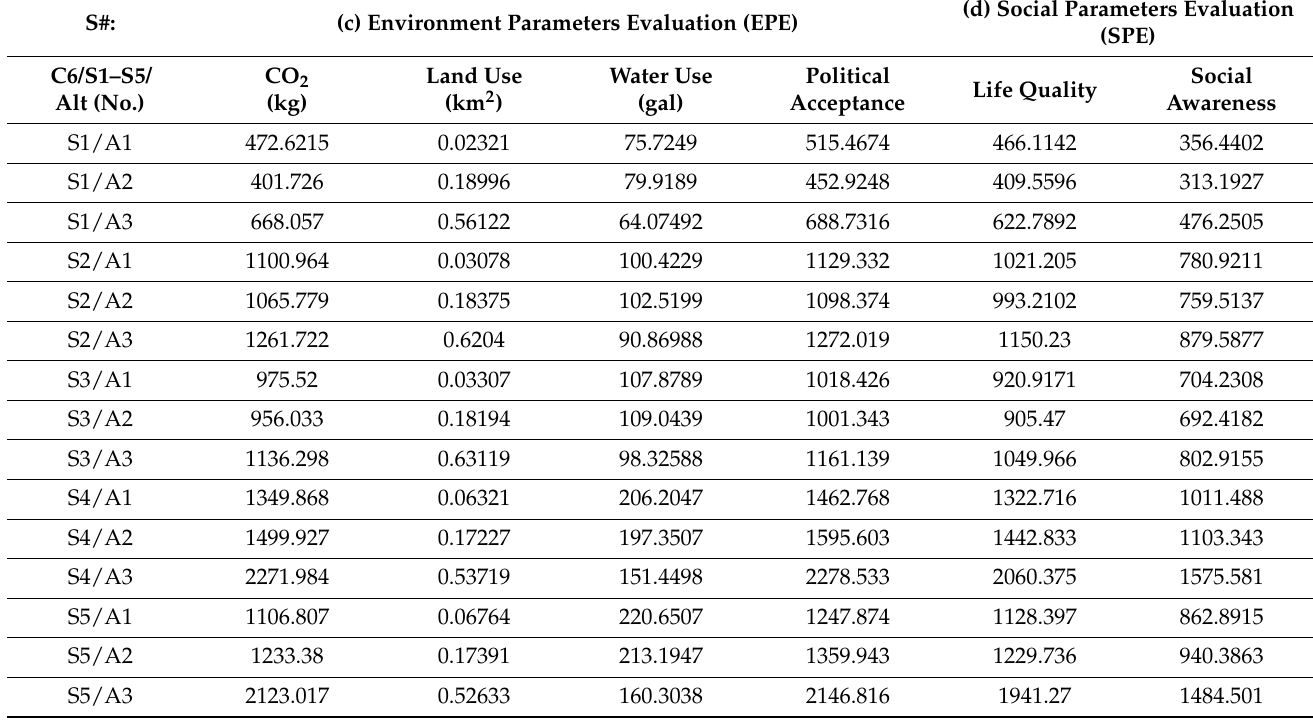
Table 27. EPE/SPE evaluations in C6/S1–S5 for the 75-bus MDN NUST_MG for